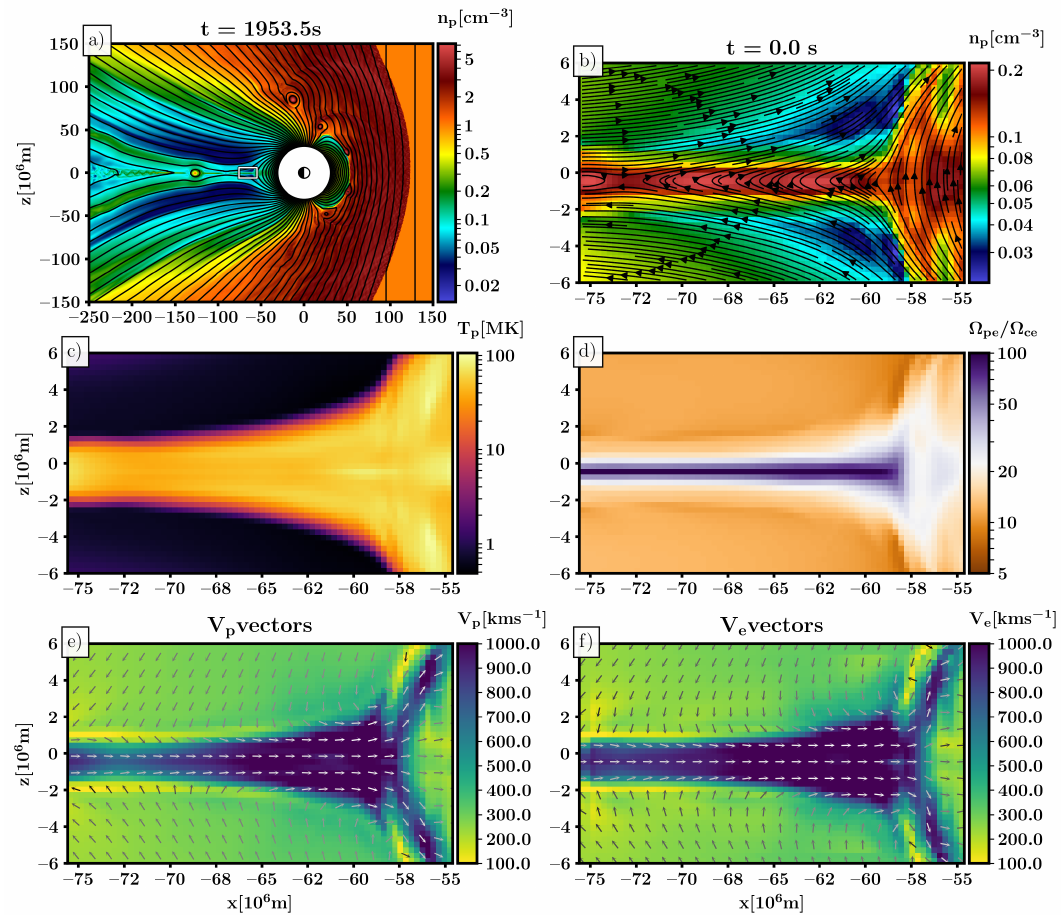
Figure 2. Simulation box initialization values. (a) Close-up of the central 16% section of the Vlasiator input simulation with plasma num- ber density overlaid with magnetic field lines. A small rectangle in the magnetotail region indicates the electron simulation domain (b–f) . (b) Proton number density overlaid with magnetic field lines. X-line topology is visible at X ∼ − 73 × 10 6 m, Z ∼ − 0 . 5 × 10 6 m. (c) Pro- ton temperature as a scalar. Electron initialization temperatures are scaled down by a constant factor 4. (d) Ratio of electron plasma and gyrofrequencies. (e, f) Proton and electron bulk velocity magnitudes with in-plane directions indicated with